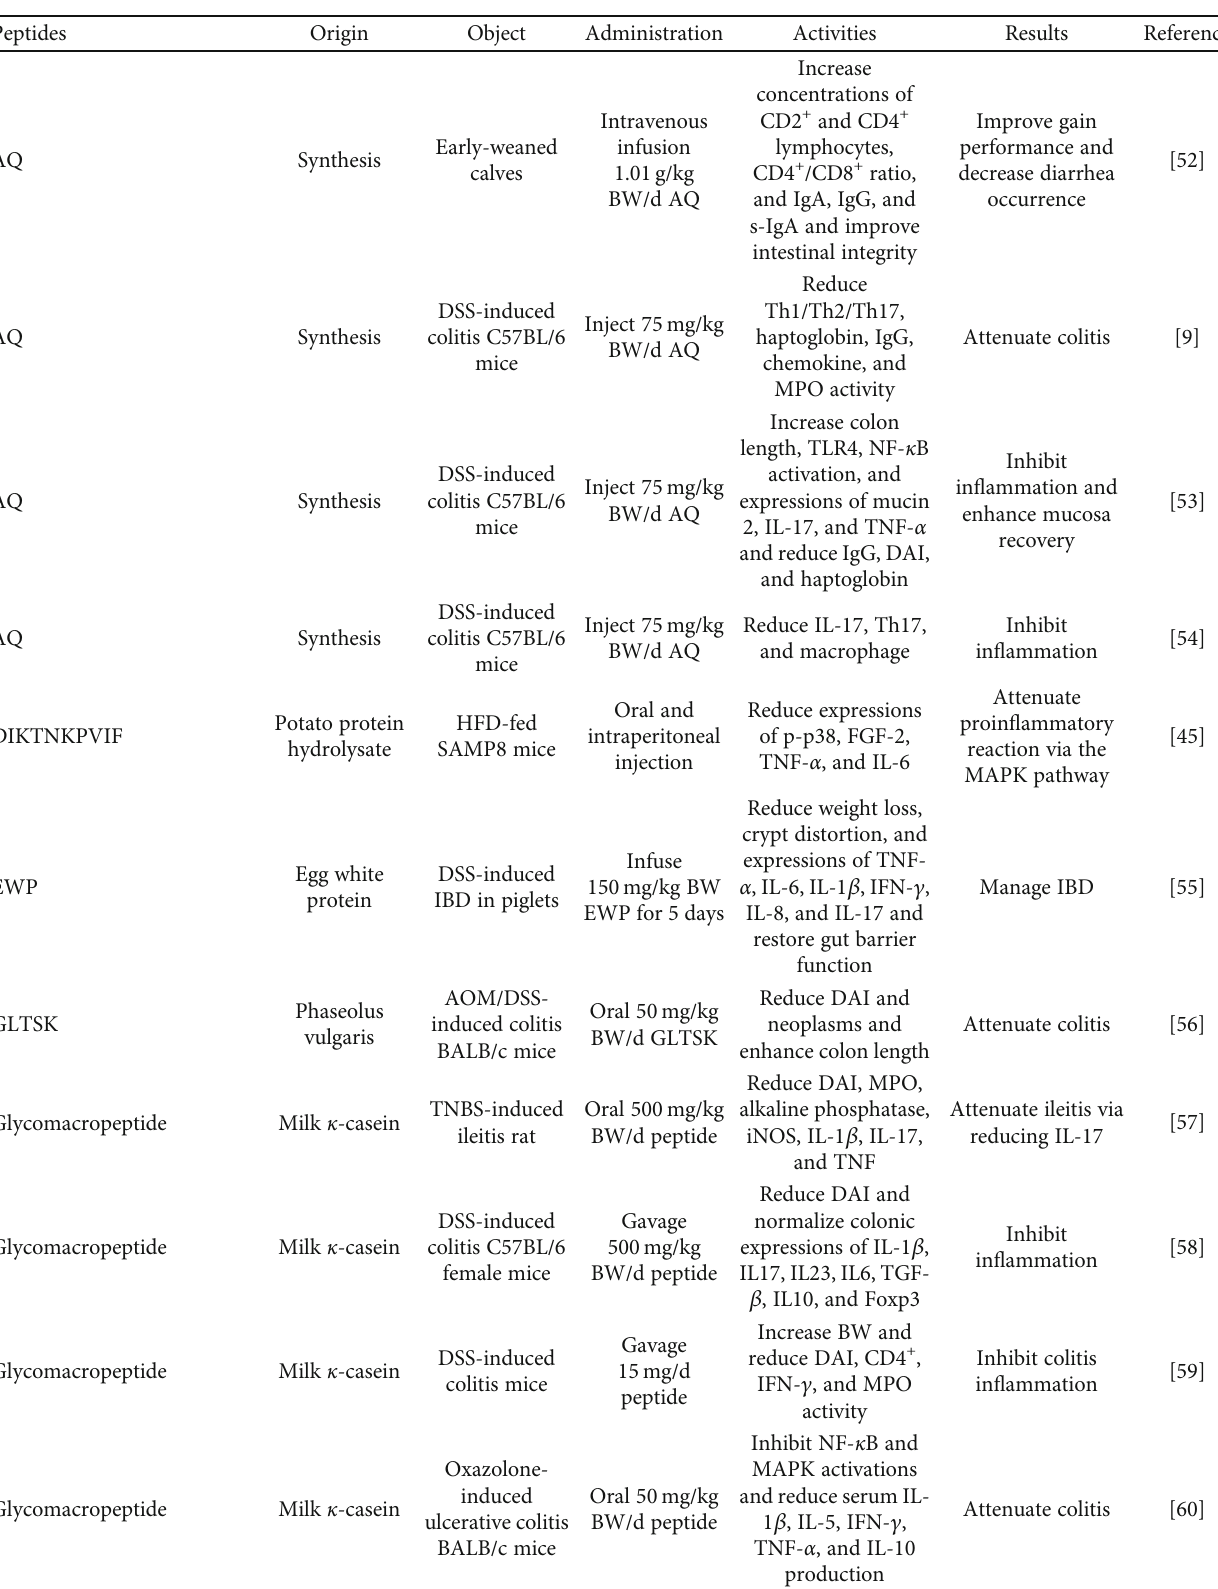
Table 2: The in vivo e ff ect of bioactive peptides on inhibiting in fl